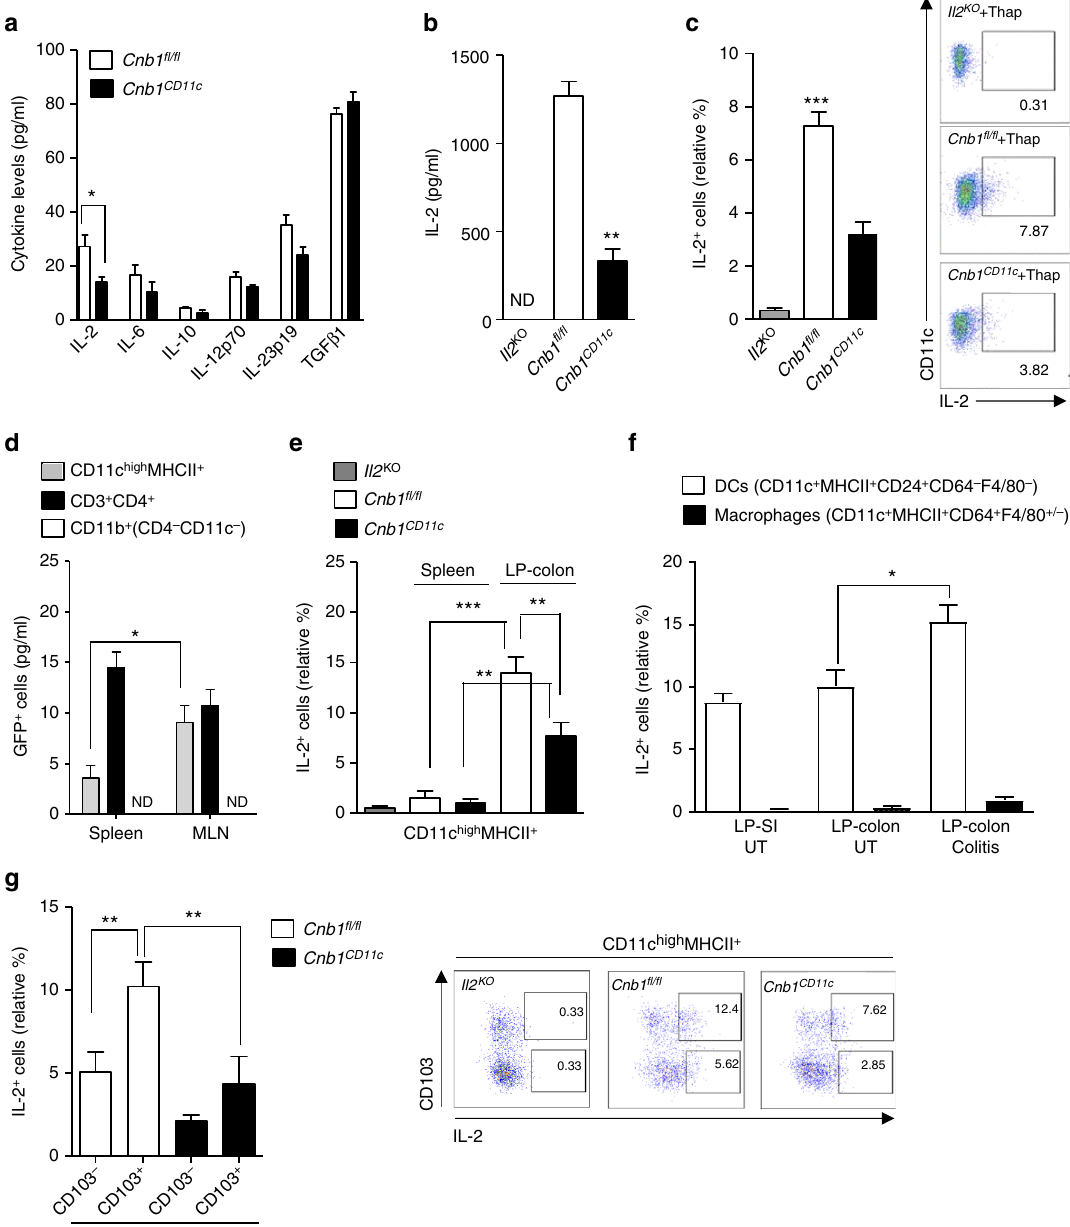
Fig. 5 Calcineurin-NFAT signaling in CD11c + MHCII high myeloid cells regulates IL-2 synthesis. a CD11c high MHCII high CD11b − cells sorted from MLN of Cnb1 CD11c and Cnb1 fl / fl mice were stimulated with thapsigargin for 16 – 20 h. Cytokine levels were measured in the culture supernatants using Luminex technology. Data represent the means± standard error of three experiments ( n = 10 mice/group per experiment). * P < 0.05. b , c IL-2 production from bone marrow-derived DCs of Il2 KO , Cnb1 CD11c , and Cnb1 fl / fl mice in response to thapsigargin stimulation for 16 h, as assessed by ELISA ( b ) and by intracellular labeling ( c ). Data represent the means ± standard error of three experiments ( n = 1 – 2 mice/group; mice aged 6 – 7 weeks old). ** P < 0.01, *** P < 0.001. d GFP (corresponding to IL-2) expression in CD11c high MHCII + cells, CD3 + CD4 + T cells, and total myeloid CD11b + (CD4 − CD11c − ) cells isolated from the spleen and MLN of IL-2-GFP reporter mice. Data represent the means ± standard error of four experiments ( n ≥ 3 mice/group). * P < 0.05. e Intracellular IL-2 labeling of colonic CD3 − CD11c high MHCII + cells from Il2 KO , Cnb1 fl / fl and Cnb1 CD11c mice. Data are presented as the relative percentage of IL-2 + cells and represent the means ± standard error of fi ve experiments ( n = 3 – 4 mice/group per experiment). ** P < 0.01, *** P < 0.001. f Percentage of IL-2 + cells in intestinal DC (CD45 + Lin − CD3 − CD11c + MHCII + CD24 + CD64 − F4/80 − ) and macrophage (CD45 + Lin − CD3 − CD11c + MHCII + CD24 − CD64 + F4/80 + / − ) populations in LP-colon and LP-small intestine of Cnb1 fl / fl mice at steady state, or during colitis induced in immunocompromised Rag1 KO mice by adoptive transfer of naïve CD4 + T cells (CD45RB high CD62L + CD44 − CD25 − ) isolated from the spleens of C57BL/6 mice. Data represent the means ± standard error of three experiments (5 – 6 mice/group). g IL-2 expression in CD103 − and CD103 + CD11c high MHCII + cells from colons of Cnb1 fl / fl and Cnb1 CD11c mice. Representative dot plots of IL-2 labeling in colonic CD3 − CD11c high MHCII + cells are shown. Data represent the means ± standard error of three experiments ( n = 2 – 5 mice/group per experiment). * P < 0.05. KO knockout, LP lamina propria, MLN mesenteric lymph node, SI small intestine, Thap thapsigargin, UT untreated, ND not